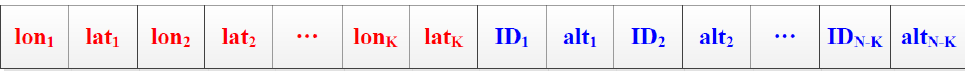
Figure 5. Illustration of chromosome encoding for N 3D sectors formed by